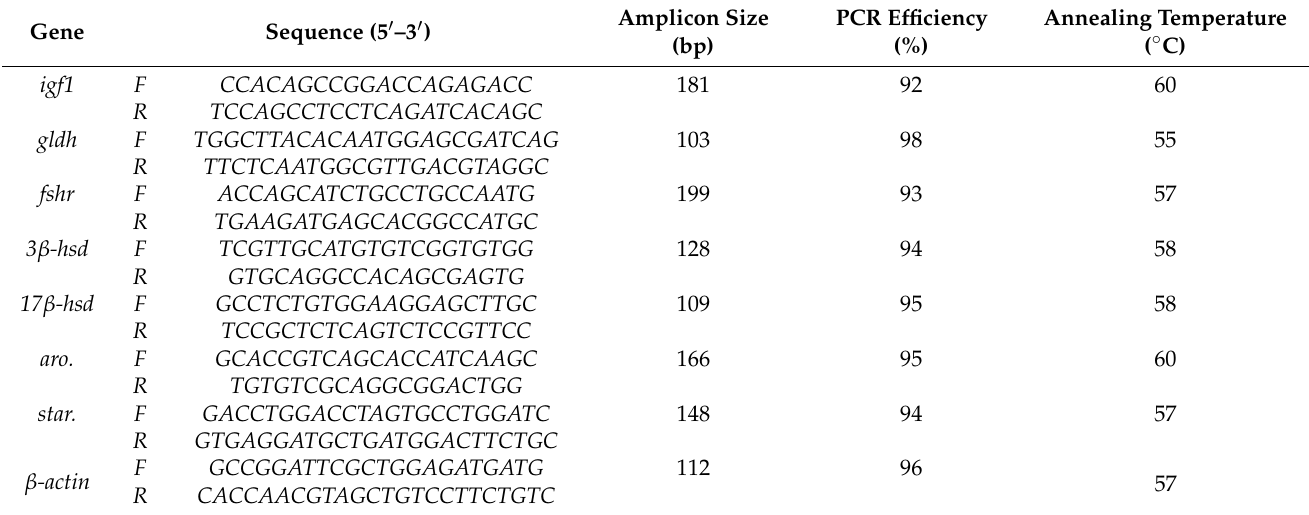
Table 3. List of primers used for quantitative PCR